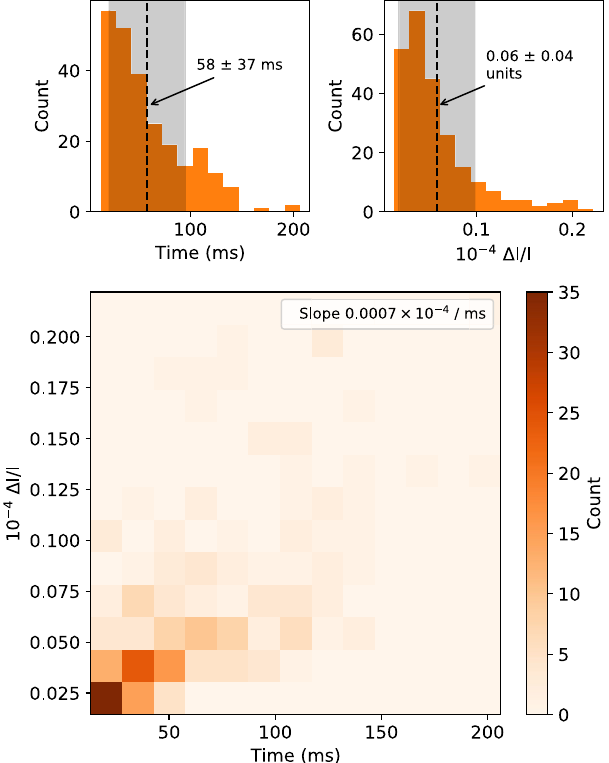
FIG. 3. Statistics of the simulation of the current error produced by the regulation loop. The top left plot shows the distribution of the rise time of the current error. The top right plot shows the distribution of the total magnitude of the current error. In the bottom plot, the distribution of the length of the current errors versus the current error magnitude is shown.